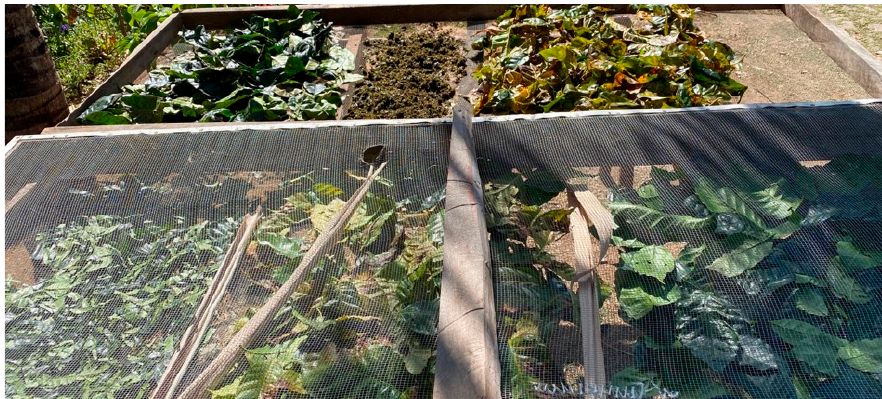
Figure 3. Sun drying of the different samples on the drying bed in Chinameca.